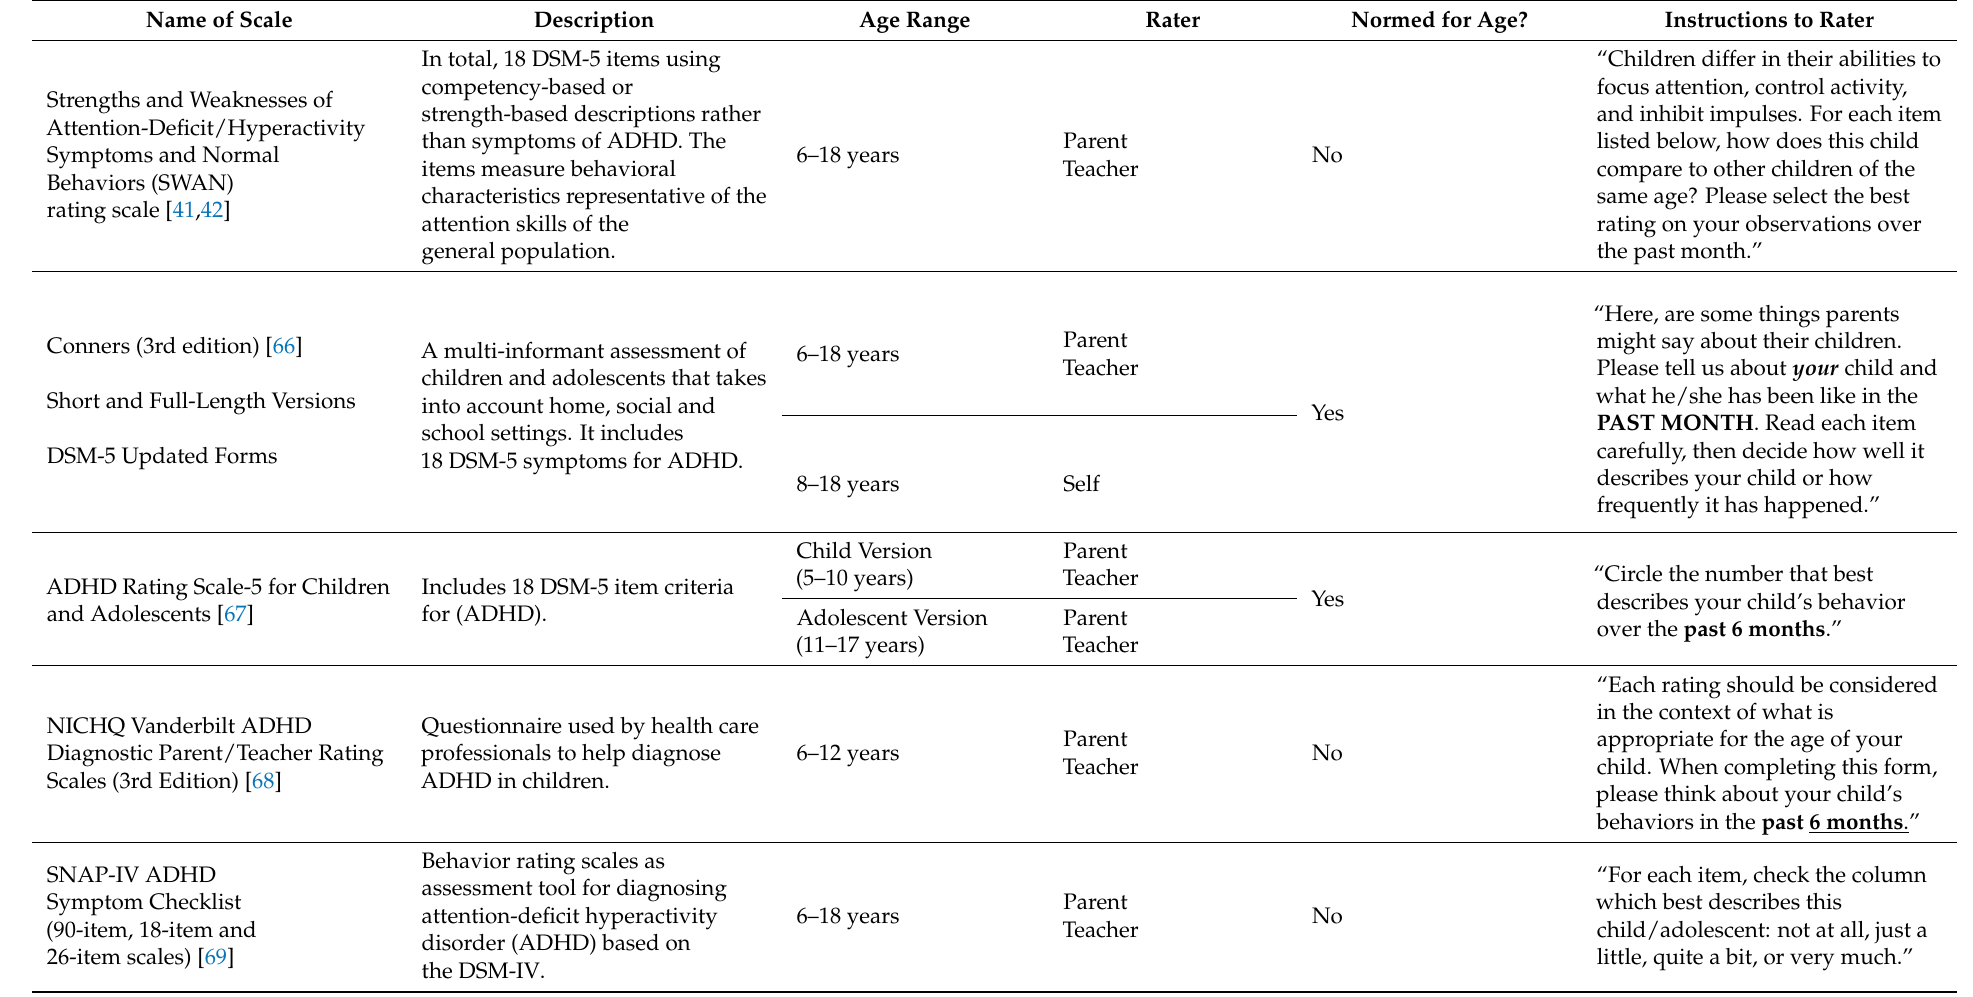
Table 5. Rating scales of attention regulation and executive functions: Availability of age-based norms and informant